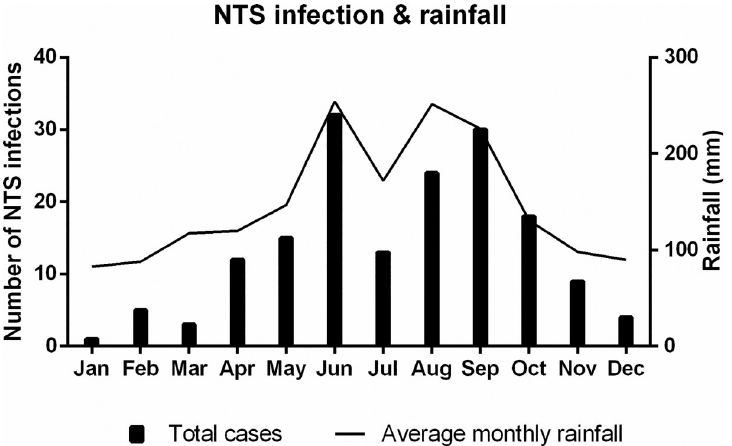
Fig 3. Distribution of 166 NTS infection cases and average monthly rainfall in Ningbo, 2012–2019. The bar chart shows the distribution of the 166 NTS infection cases according to the month of admission. The average monthly rainfall over the 8-year study period in Ningbo is shown in the line graph. Abbreviations: NTS = non-typhoidal Salmonella , Jan = January, Feb = February, Mar = March, Apr = April, Jun = June, Jul = July, Aug = August, Sep = September, Oct = October, Nov = November, Dec = December.